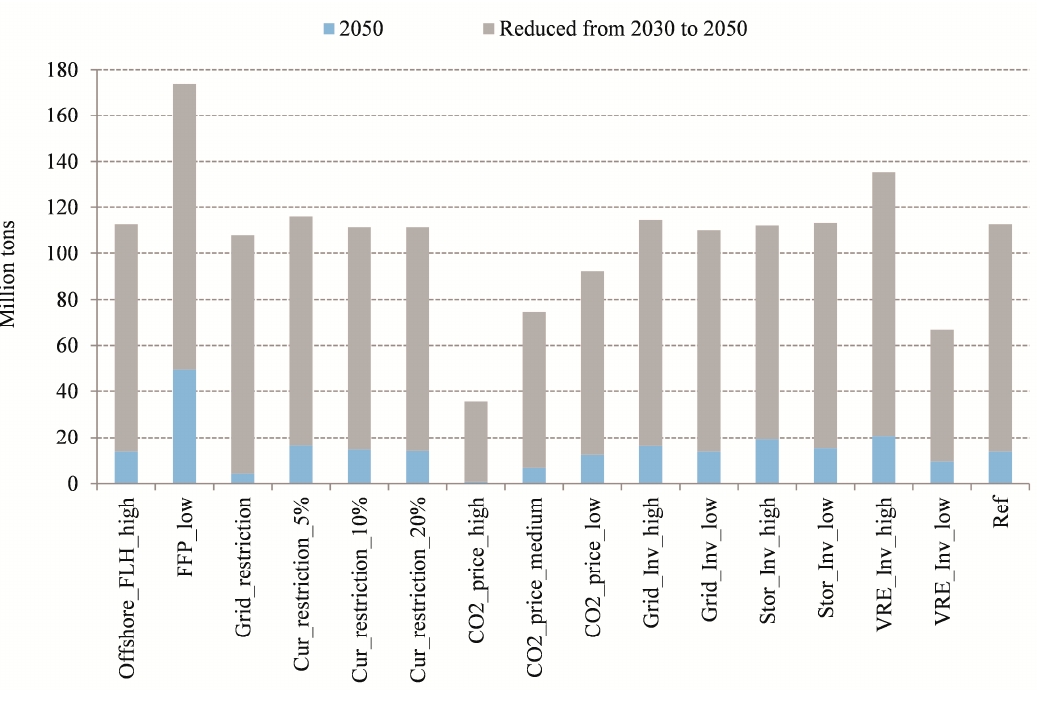
Figure 20. Sensitivity analysis on CO 2 emissions in Inner Mongolia of 2030 (whole column) and 2050 shown as deviations from the reference scenario.